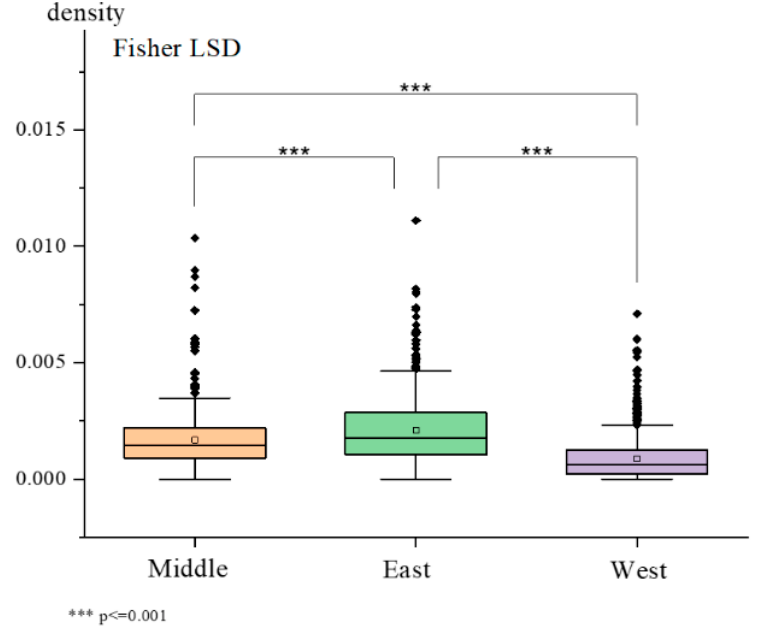
Figure 6. Paired comparison plot of land used for transportation at the county level in the eastern, central, and western regions of China.